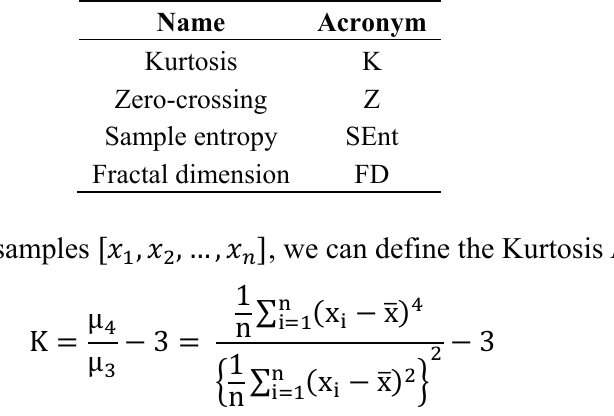
Table 5. Names and acronyms of the considered statistical